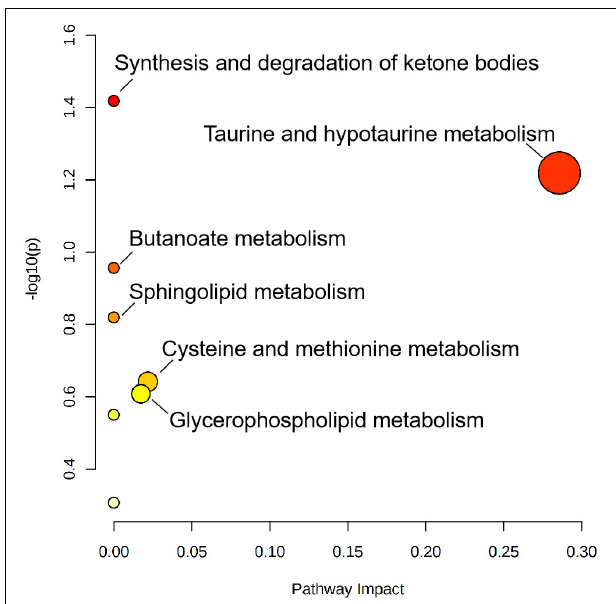
FIGURE 8 | Metabolic pathway analysis results of SGA newborns, presented by bubble graph. Each bubble represents a metabolic pathway. The x -axis of the bubble and its size represent the impact factors of the pathway in the topology analysis. The y -axis of the bubble and its color represent the p -value of enrichment analysis [represented by the negative natural logarithm, -ln(P)]. The color intensity reflects the corresponding p -value and the enrichment